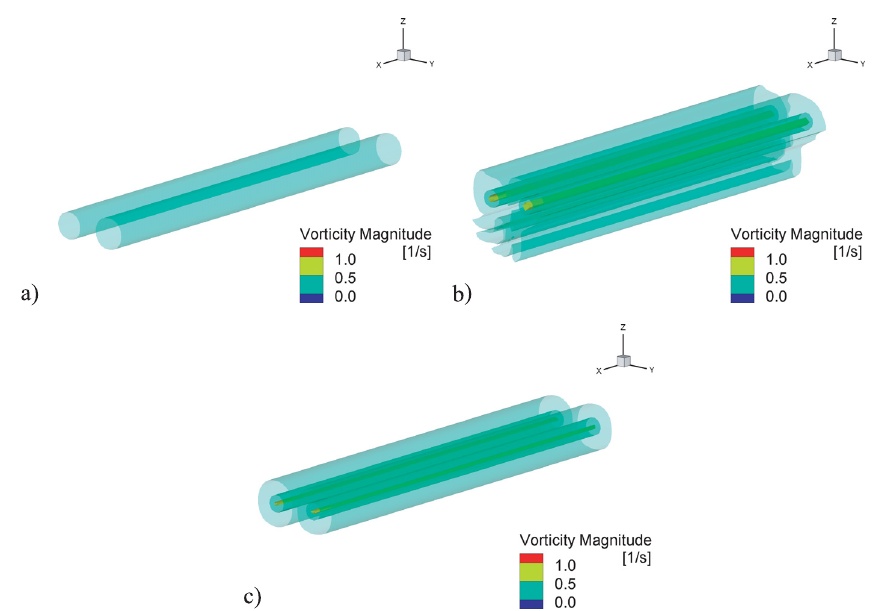
Fig. 6 Structure of a vortex pair visualized by iso-vorticity surface at several iteration step, a) 1st iteration, b) 16th iteration, c) 32nd